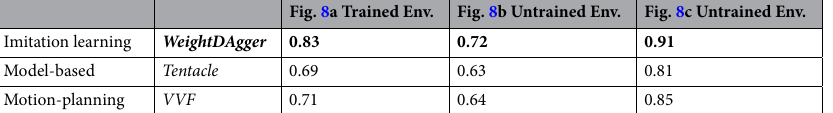
Fig. 8a Trained Env. Fig. 8b Untrained Env. Fig. 8c Untrained Env.